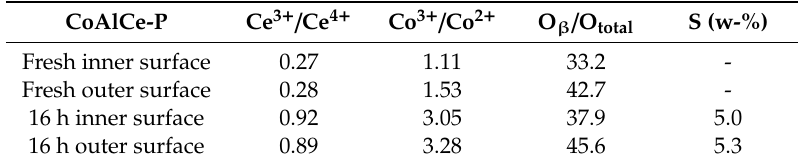
Table 8. Surface compositions of fresh and 16 h CoAlCe-P as estimated by XPS.